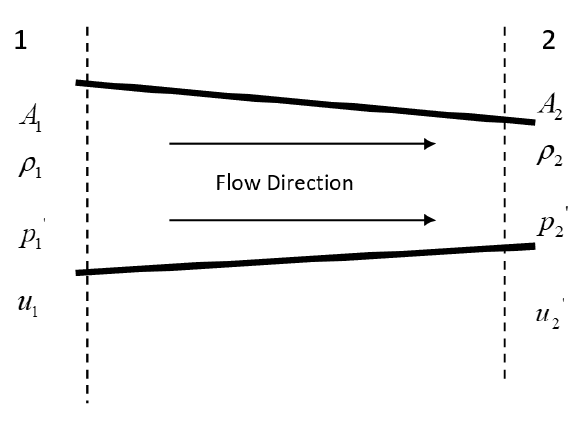
Figure 1. Diagrammatic sketch of a variable diameter pipe.